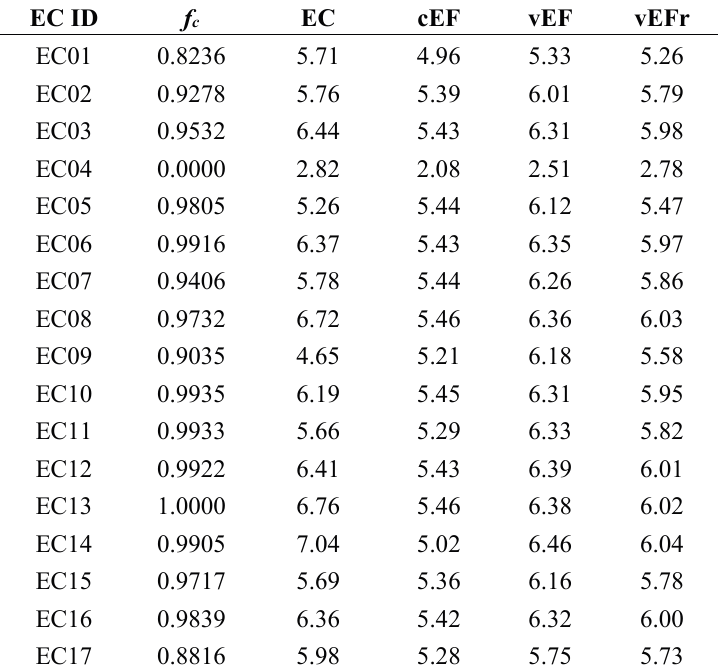
Table 4. Evapotranspiration (ET) validation on 10 July of 2012 (units: mm·d − 1 ).